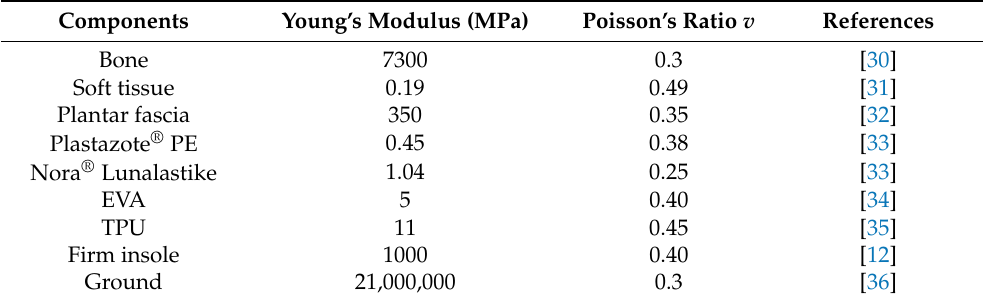
Table 1. Material properties of components of the foot model with customized insole without heel pad and with heel pad and heel–forefoot pad used in the finite element analysis.